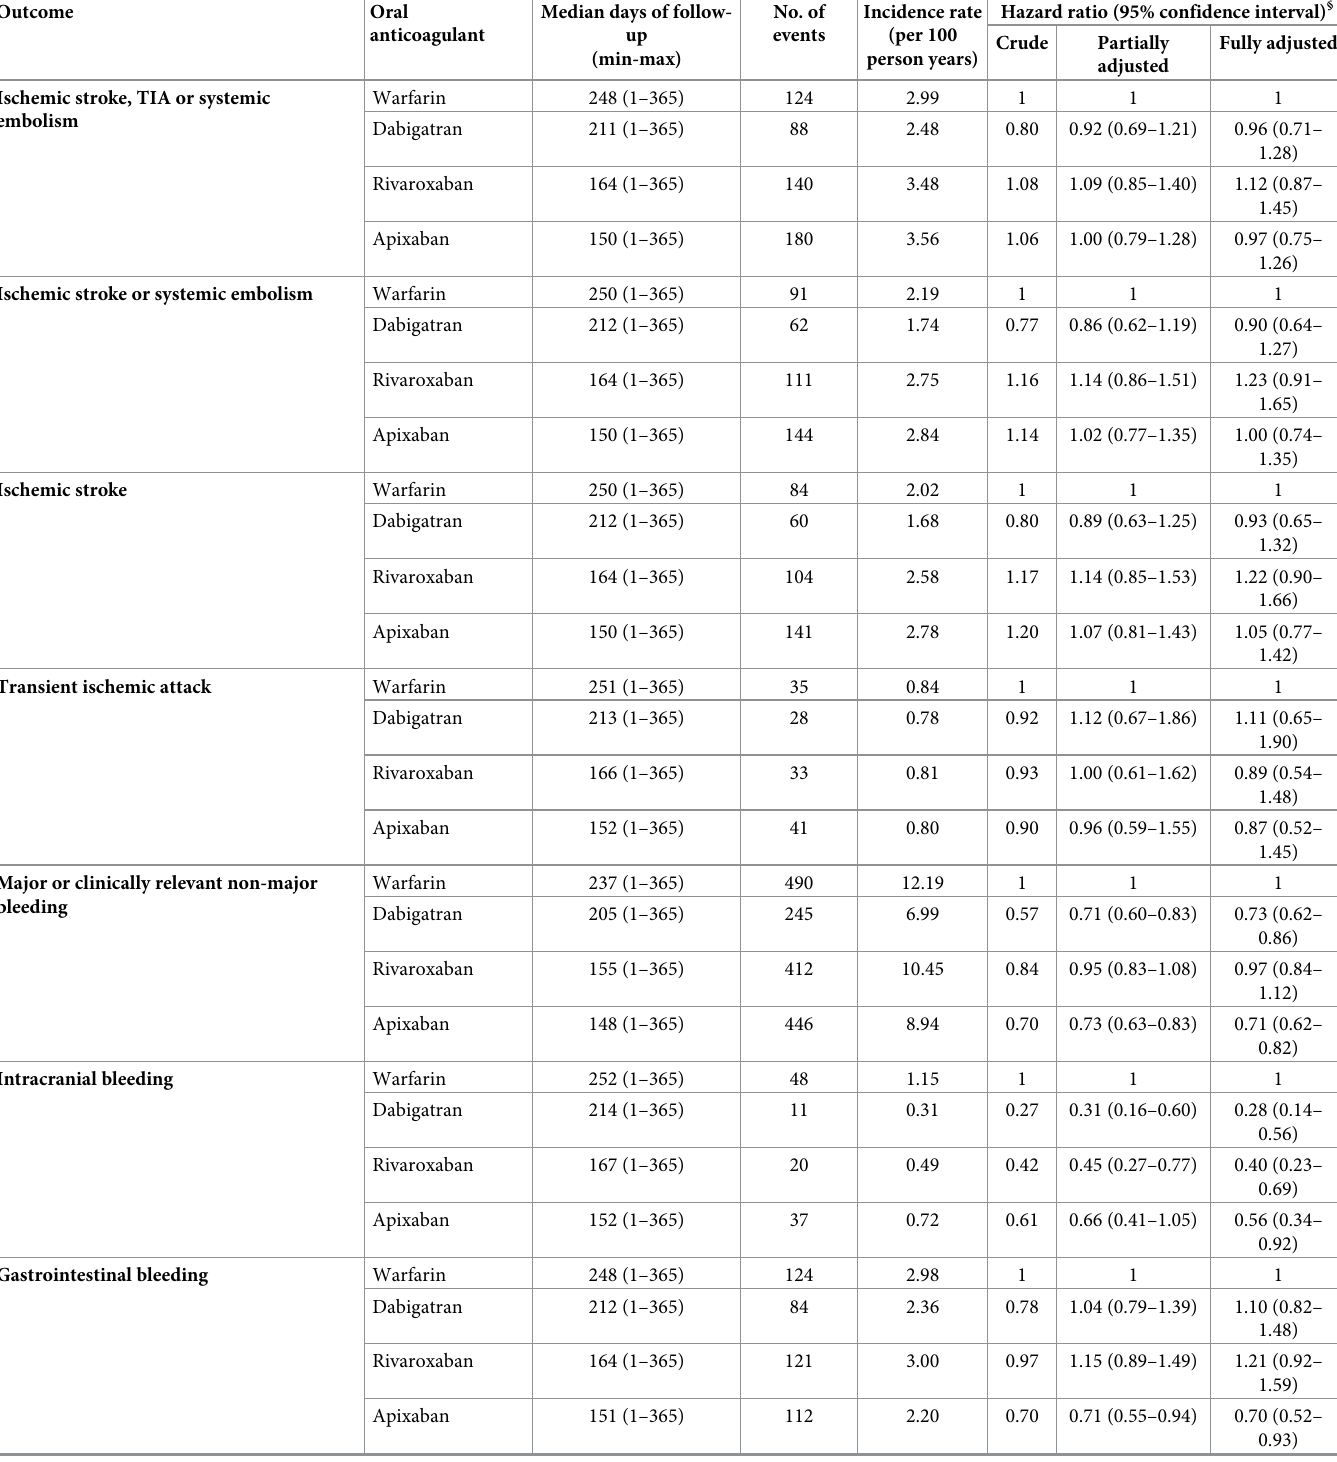
Table 2. Median days of follow-up, number of events, crude incidence rate per 100 person years and hazard ratio of effectiveness and safety outcomes in new users of dabigatran, rivaroxaban or apixaban compared to warfarin for non-valvular atrial